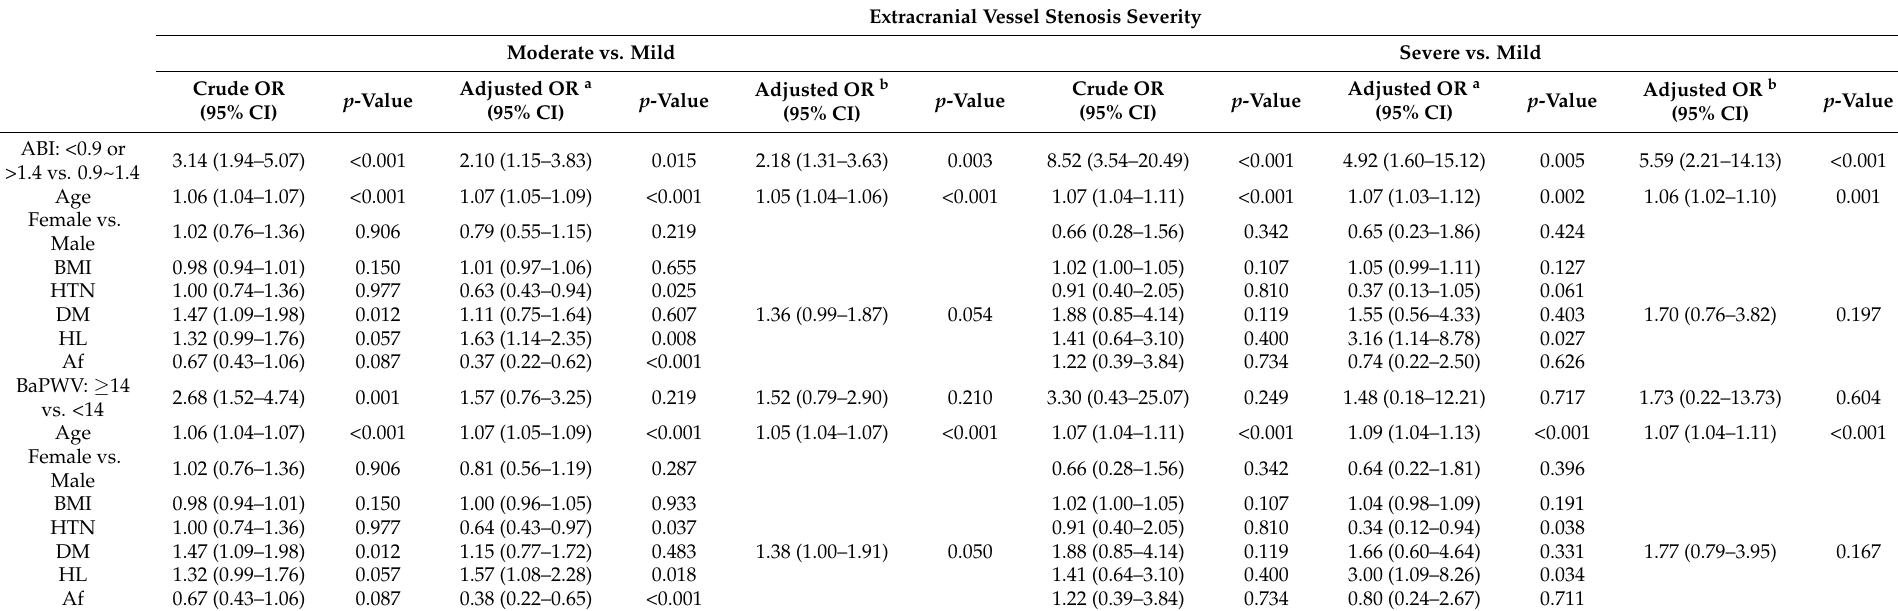
Table 1. Multinomial logistic regression for predictors of extracranial vessel